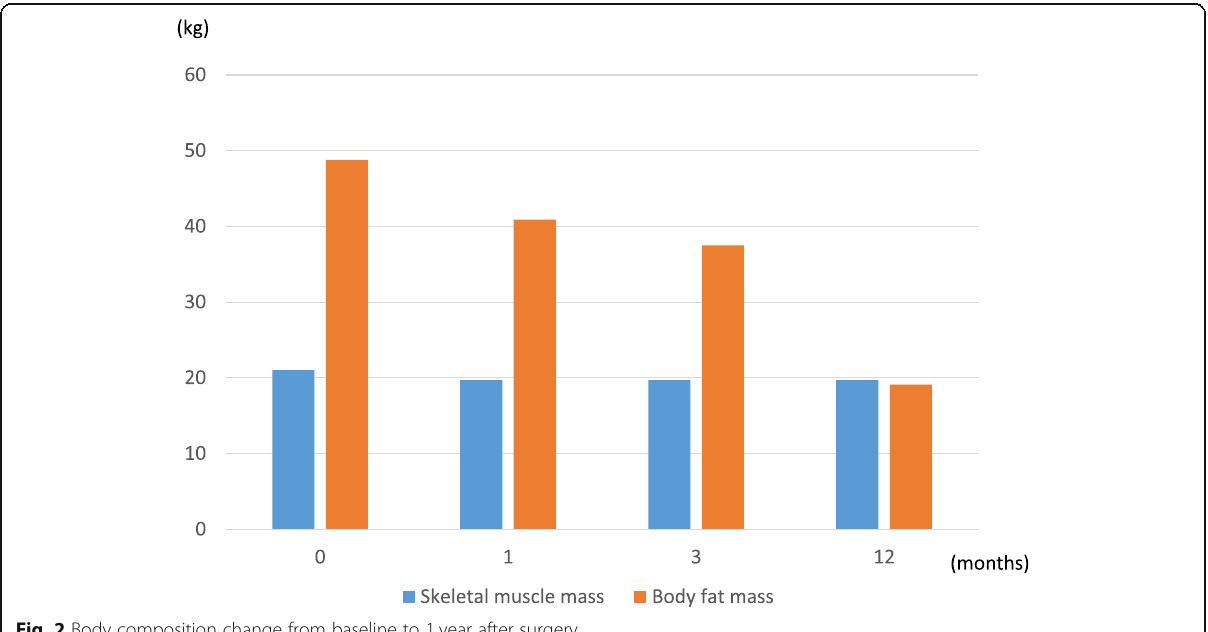
Fig. 2 Body composition change from baseline to 1 year after surgery